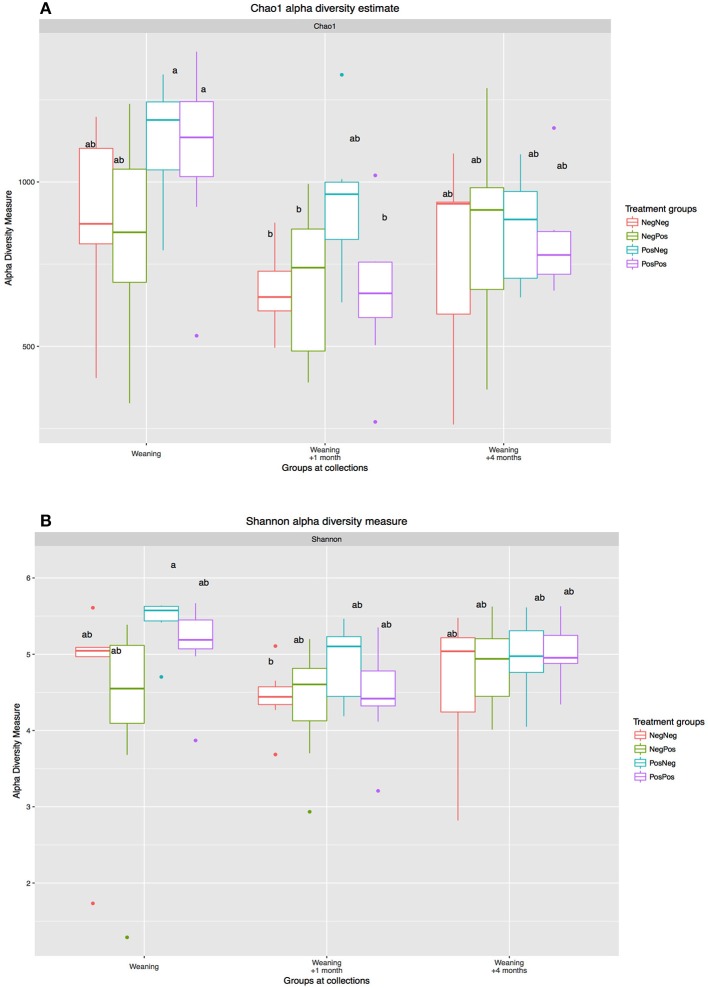
Alpha diversity measures: (A) Chao1 taxonomic units estimates and (B) Shannon diversity index): W, W + 1, and W + 4). Treatment groups: D–k–= NegNeg, D–k+ =NegPos, D+k– = PosNeg, D + k+ =PosPos. a,bLetters denote significant differences between groups, bars that do not share the same letter are significantly different from each other (P < 0.05).